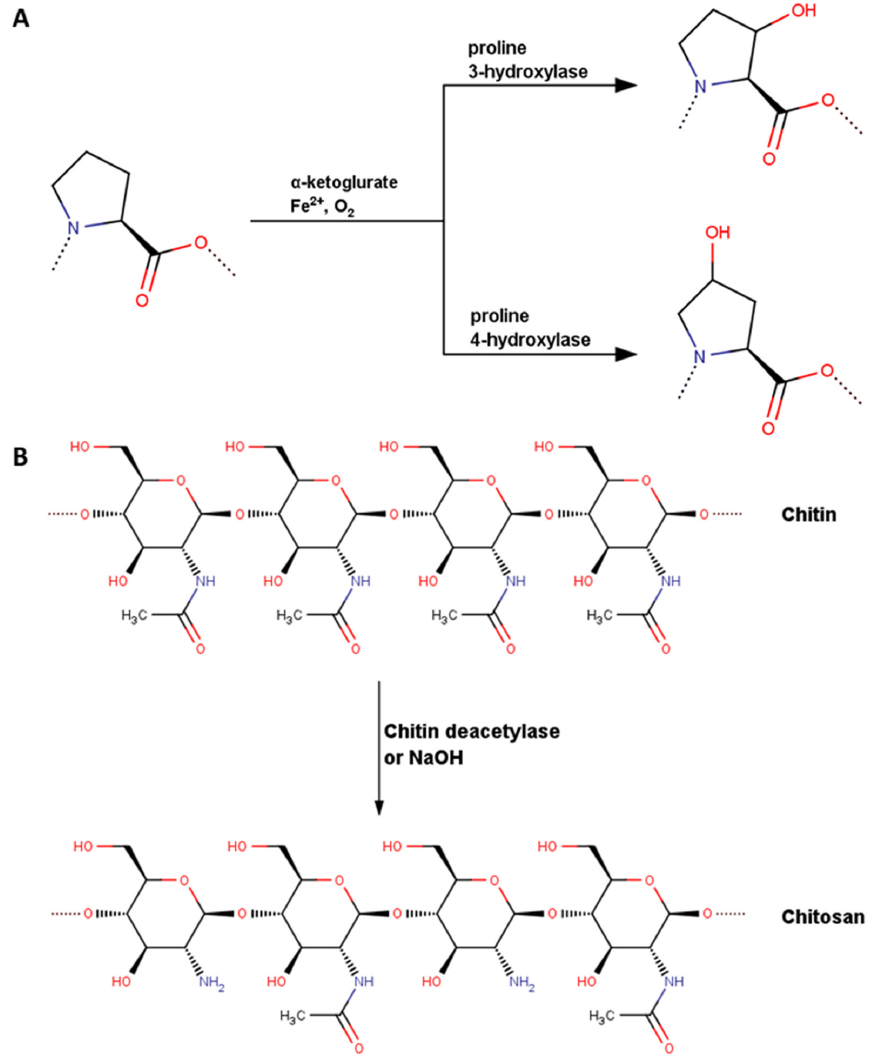
Figure 1. The enzymatic hydroxylation of the PRO moiety in collagen ( A ) and deacetylation of chitosan ( B ). In case of the reaction scheme shown on the panel A, L-proline moiety is hydroxylated, which is a natural isomeric form in collagen. In the current study the hydroxylation of the same PRO form yielding trans-4-Hydroxy-L-proline residues was taken into account.